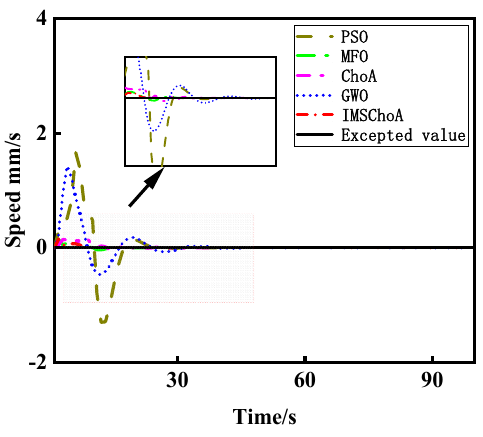
Figure 15. Speed curve. Figure 15. Speed